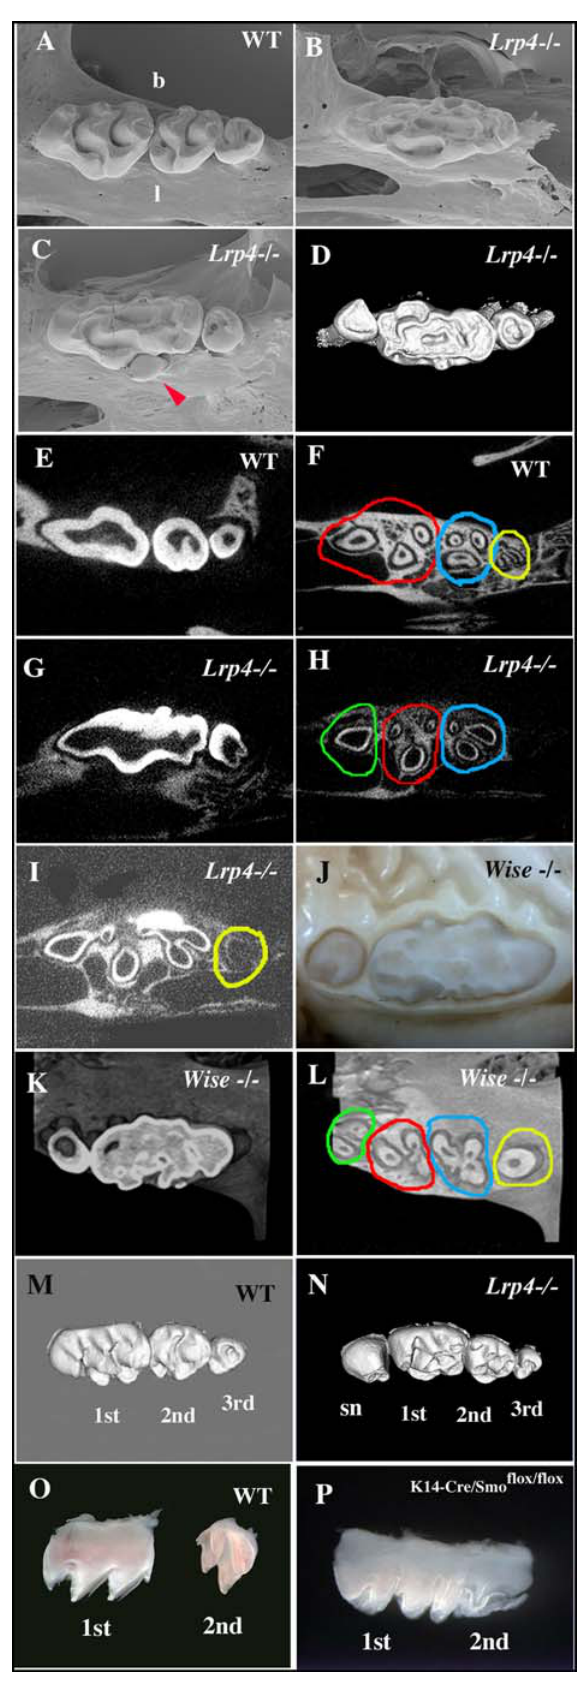
Figure 4. The molar tooth phenotypes of Lrp4 mutant mice and Wise mutant mice. SEM images of maxillary molars (A–C), 3D reconstructions based of micro CT scans (D, M and N), horizontal micro CT sections (E–I, K and L) and dissected maxillary molars (O and P) of adult wild-type (A, E, F, M and O), Lrp4 mutants (B–D, G–I and N) adults, Wise mutants (J–L) and K14-Cre/Smo flox/flox mice (P) of adult (A–N) and P6 (O, P). One fused molar (B), fused molar with one relatively normal size tooth and lingual peg-shaped extra tooth (arrowhead in C), and fused molar with two reratively normal size teeth (D). Horizontal micro CT sections at the crown region (E and G) and root region (F, H and I). (F) In wild type, there are three groups of tooth roots in maxillary molars (red circle=three roots of the first molar; blue circle=three roots of the second molar; yellow circle=two roots of the third molar). (G–I) In Lrp4 mutants, the fused molar with one normal size tooth showed four groups of tooth roots, indicating that a supernumerary tooth was present in the quadrant. The fused molars (H) had three groups of roots (one root in green circle; three roots in red circle; three roots in blue circle in H), and one normal size molar had one root as one unit (yellow circle in I), suggesting that the fused molar includes the supernumerary tooth. At the horizontal section level showing the tooth roots of the fused molars, the roots of a normal size molar could not be seen (H). Fused molars were also found in the maxillae of Wise mutant mice (J). Wise mutant fused molars also showed the several groups of roots (K and L). Supernumerary teeth were observed anterior to the first maxillary molar tooth (sn in N) of Lrp4 mutant mice (N). Fused maxillary molar of K14-Cre/Smo flox/flox mice (P). b; buccal side, l: lingual side. In all images, left side is anterior side. Scale bar=1 mm.